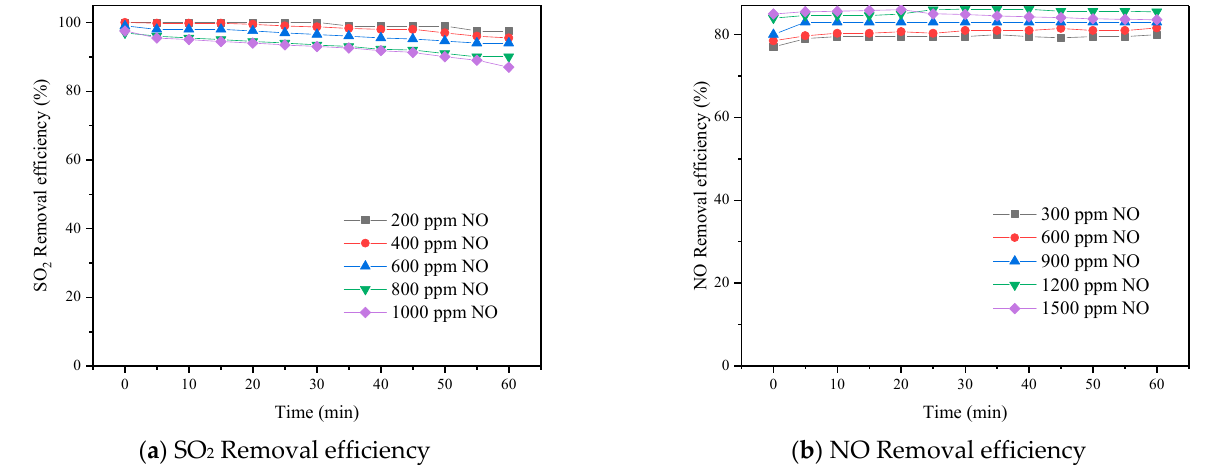
Figure 4. Effect of NO concentrations on denitration and desulfurization ([SO 2 ], 1000 ppm; n O , 1.2; inlet gas temperatures 200 °C; artificial seawater was 30 L).